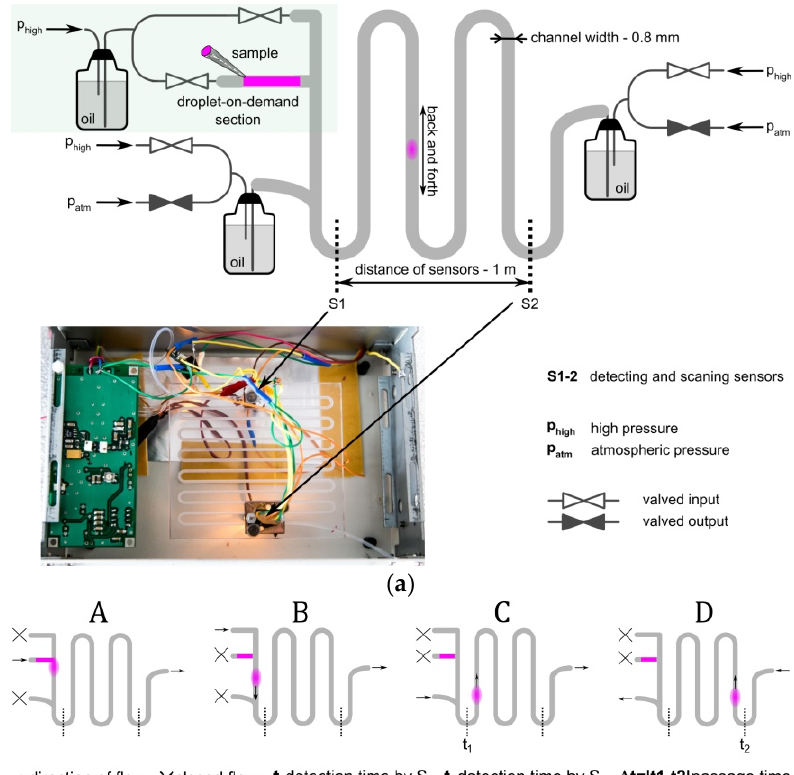
Figure 1. ( a ) Schematic of the microfluidic device used in the experiments. The photograph shows the central part of the system with marked sensors (see also Figure S1). ( b ) A – D show the procedure of the droplet generation in a (A,B) droplet-on-demand section and the (C,D) cycling of a droplet back and forth between sensors.